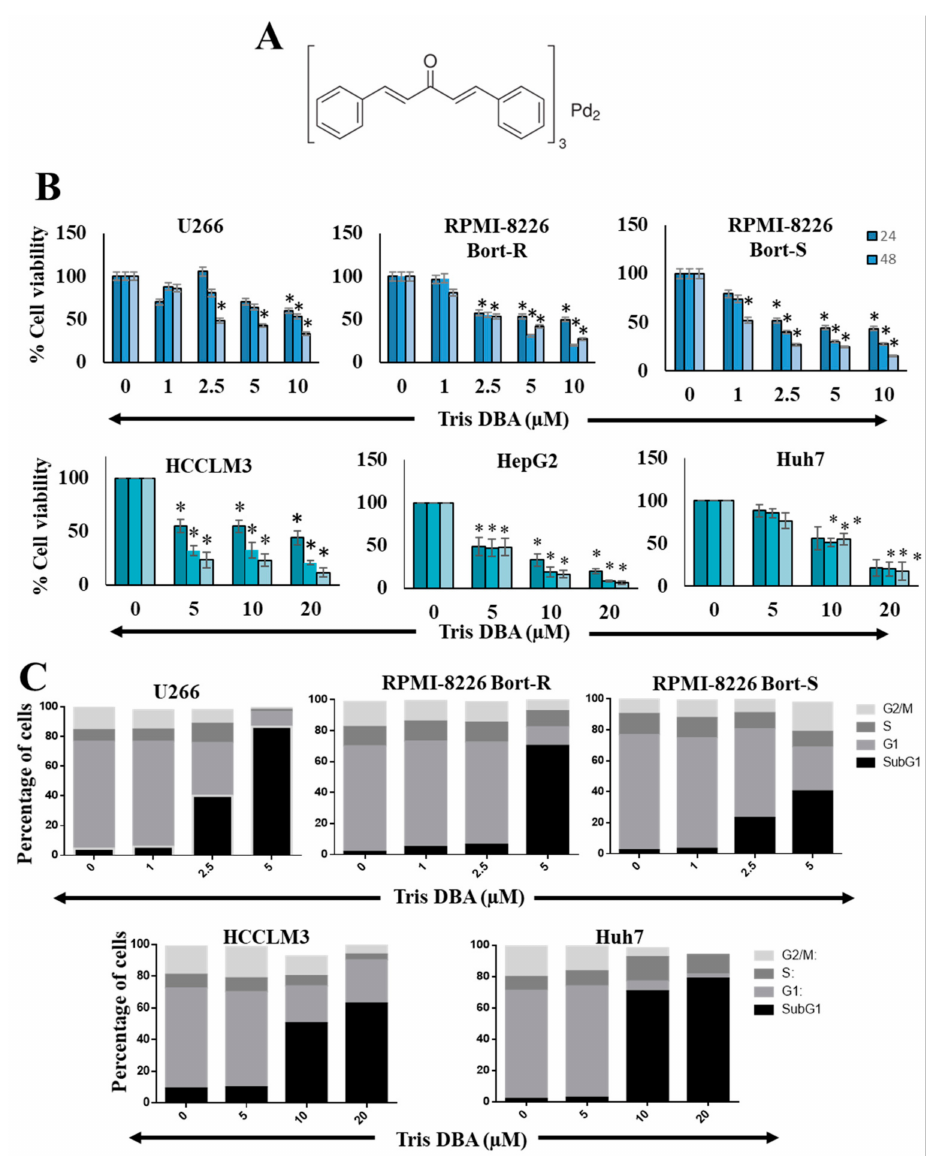
Figure 1. Tris DBA decreases cell viability. ( A ) The structure of Tris DBA. ( B ) The efficacy of Tris DBA on the viability of MM (U266, and RPMI-8226) and HCC (HCCLM3, HepG2, and Huh7) cells was examined by MTT assay at different time-points and concentrations. Bars indicate standard deviation; * p < 0.05 versus no treatment (no treatment is 0.1% DMSO). The experiments were repeated thrice. ( C ) MM (U266, and RPMI-8226) and HCC (HCCLM3, HepG2, and Huh7) cells were incubated with Tris DBA and analyzed using flow cytometry to determine the distribution of cells across the cell